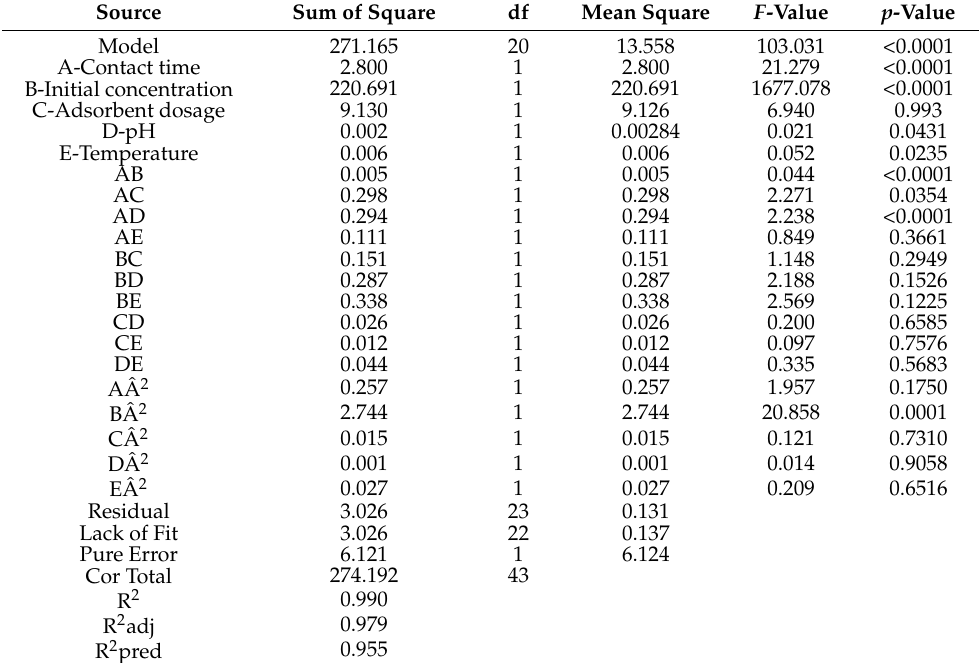
Table 4. Analysis of variance (ANOVA) for dicamba